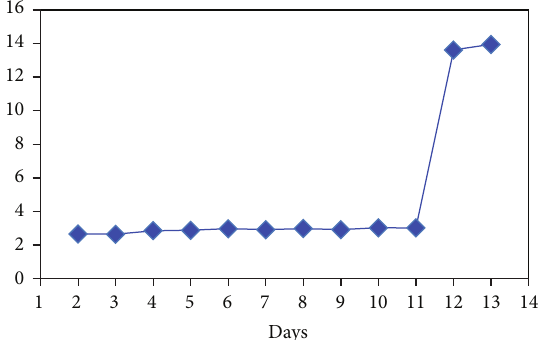
Figure 13: Kurtosis value during the test for all days.